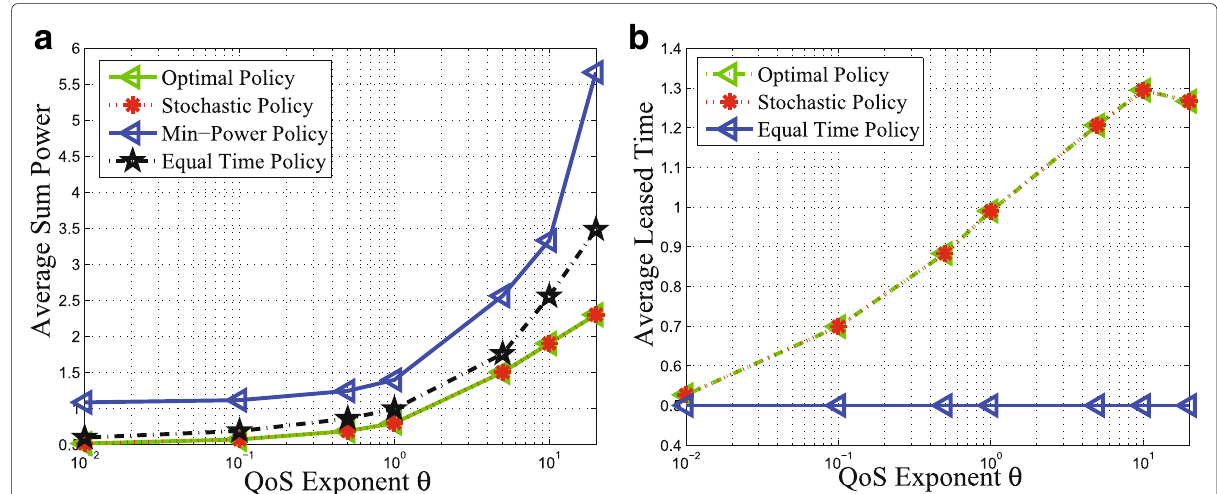
Fig. 7 a , b Average sum power and leased time versus delay QoS exponent θ with DF relay protocol when { ω 1 = 0.8, ω 2 = 0.2 } is